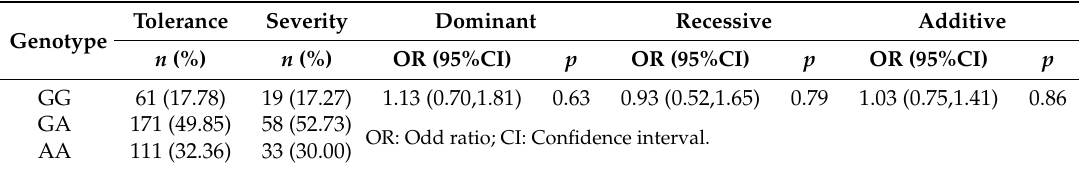
Table 7. Association between CASC8 rs10505477 and platinum-based chemotherapy hematologic toxicity in lung cancers.